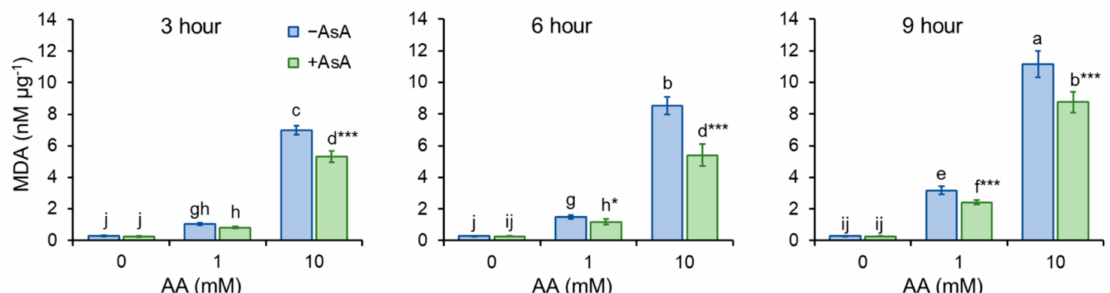
Figure 5. MDA formation. AA triggers oxidative stress resulting in lipid peroxidation. As indicated by enhanced MDA production, AA causes peroxidation of membrane lipids in a dose dependent manner. AsA pre-treatment protect cells from AA-triggered oxidative stress, as it significantly reduces MDA production. Bars represent mean ± SD of 4 individual samples. Statistical significance is determined by Duncan’s post-hoc test, different letters above bars indicate statistical difference as p < 0.05 *, 0.001 ***.